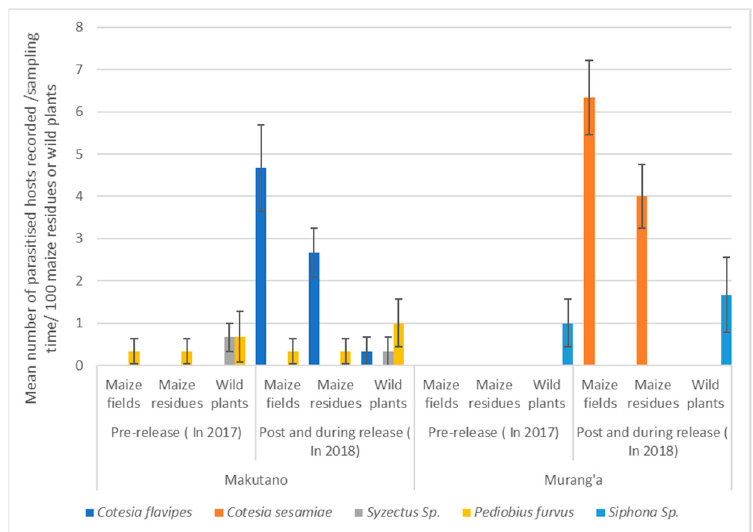
Figure 5. The mean number (±SE) of parasitoid species recovered per field in maize residues or wild plants during non-cropping seasons as well as in maize plants of cultivated fields during the subsequent cropping seasons in Makutano and Murang’a before (pre-release) and after or during (post and during release) Cotesia flavipes and Cotesia sesamiae releases.